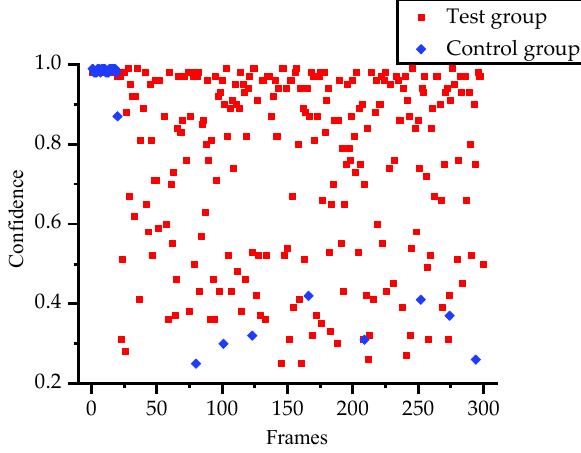
Figure 9. Confidence contrast scatter diagram, where the control group is the system without any stabilization methods, the test group is the visual sensor stabilization system, and the first period is stationary.